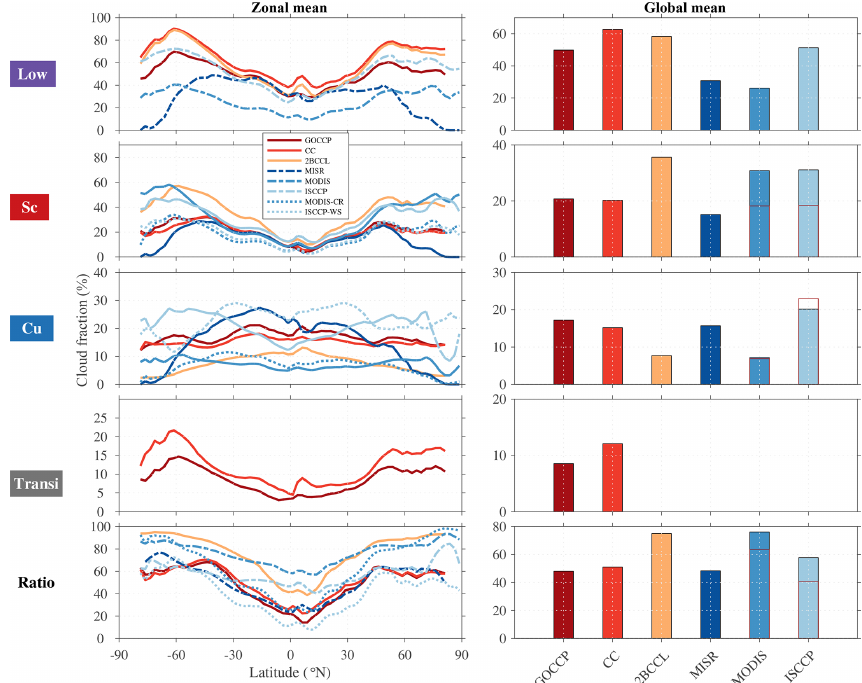
Figure 14. Global zonal mean (%, left) and global area-weighted mean (%, right) of low, Sc, Cu, transitioning (i.e., broken Sc, Cu under Sc and Cu with stratiform outflow), and the ratio Sc to Sc–Cu clouds – from the top to the bottom – for all the satellite datasets using the same time period as in Fig. 13. Active-sensor observations are represented in solid lines as opposed to dashed lines for COT–CTP passive-sensor observations and dotted lines for clustering passive-sensor observations. The clustering area-weighted means are represented by transparent bars with red borders. Note that the y axes are different in every subplot. All datasets are averaged onto a 2.5 ◦ × 2.5 ◦ grid.